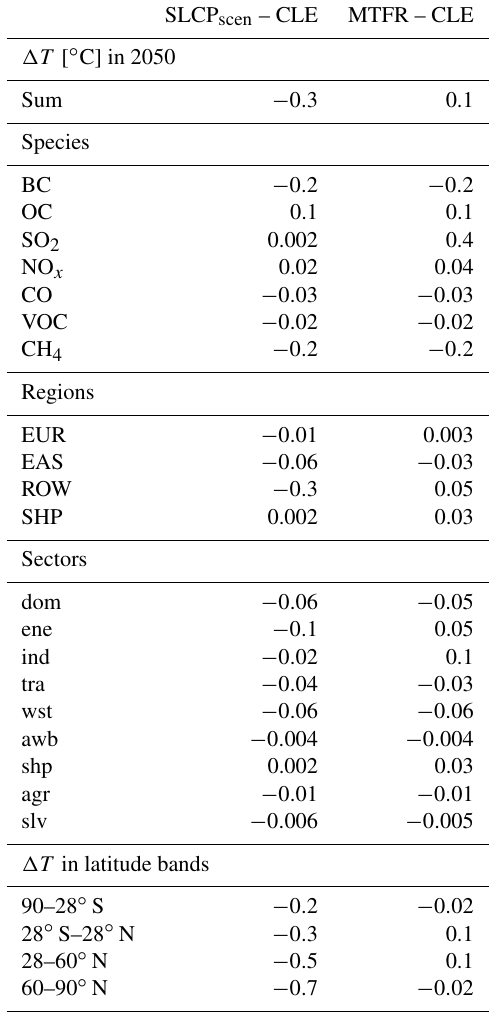
Table 2. The global and regional temperature responses in 2050 for SLCP scen and MTFR scenarios relative to the baseline CLE. Global temperature responses are given for the net, as well as for all the species, emission regions, and emission sectors at a global level. In the lower part, temperature responses in the four latitude bands are shown for global emissions. This table is a synthesis of Figs. 2–4. The sectors included are agriculture (agr),